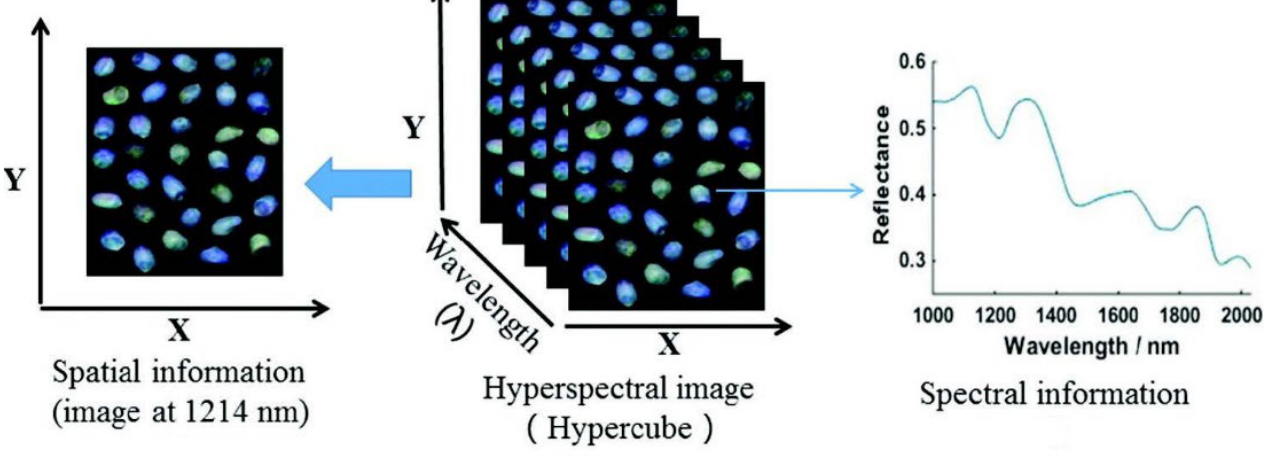
Figure 2. Spectrum and spatial information of peanut samples obtained by the HSI technology [29].